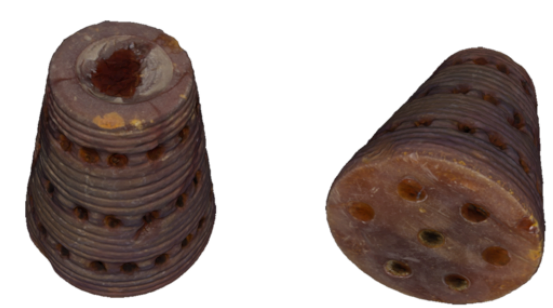
Figure 8. Final 3D model accepted for one of the processed objects.